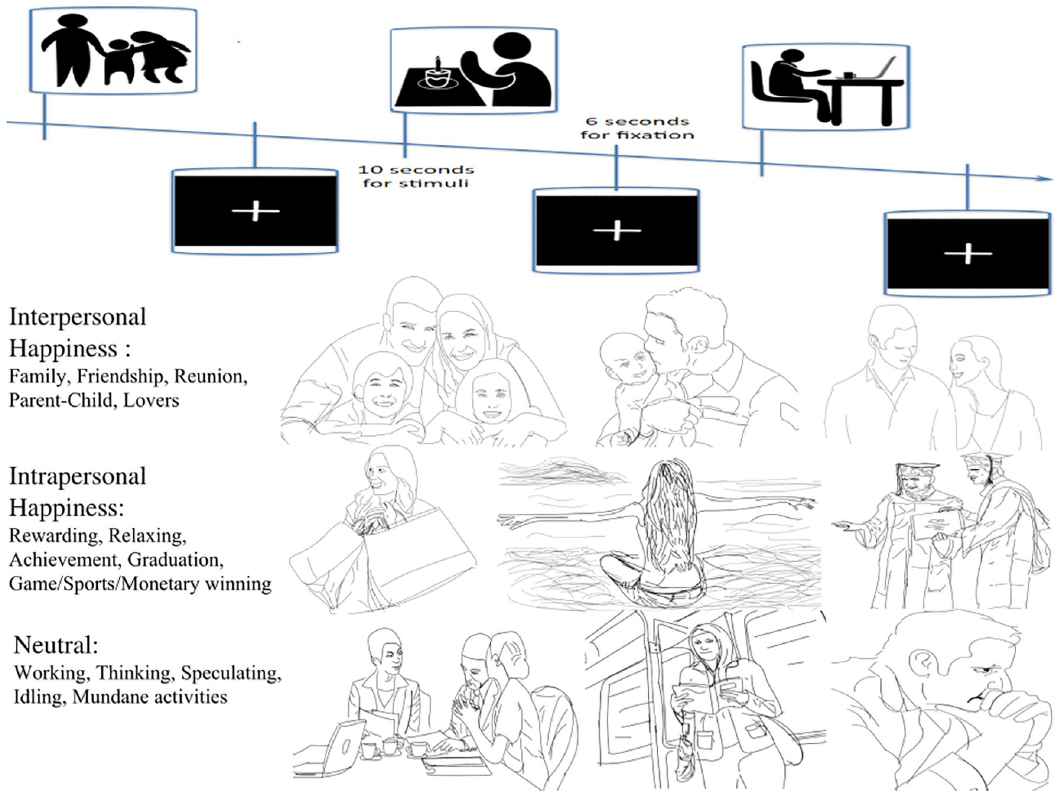
Fig 1. The experimental procedures (top) and examples of stimuli displayed during the experiment (bottom). Three different categories of pictures were googled and rated by a separate group (procedures detailed in the method section): (a) interpersonal/ other-concerned wellbeing, including: merry couples, happy family, or company with children, loved ones or significant others); (b) intrapersonal/self-concerned wellbeing, including materialistic reward, tasting delicious food, or winning in sports); and (c) neutral conditions: daily work, mundane moment, walking after work, or idling, etc. To circumvent image copyright issue, the examples shown here were further restricted to include only ‘free for non-commercial reuses’ in Google image search options. The complete set of 550 stimulus pictures of the current study were accessible in public Google Drive (https://drive.google.com/open?id=